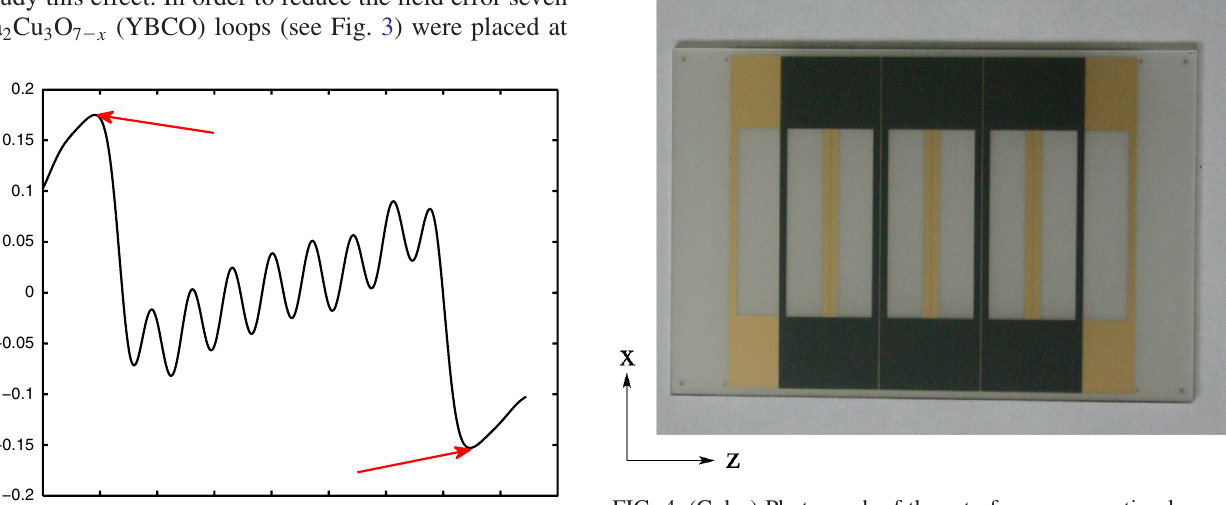
FIG. 4. (Color) Photograph of the set of seven correction loops. Two 500 (cid:3) m thick sapphire substrates are sputtered with four and three YBCO loops with a thickness of 330 nm. The YBCO loops are covered with a 200 nm thick gold layer. The dimen- sions of the loops are 14 mm (equal to the period length of the undulator) times 44 mm. The two substrates are stacked in the way shown in the figure and mounted at a distance of 1 mm from the surface of the